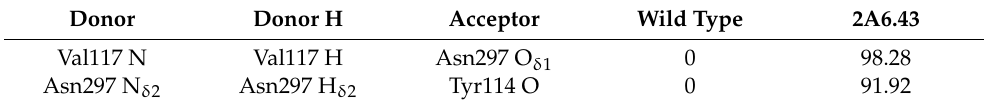
Figure 11. Structural change in CYP2A6.43 ( A – C ). The wild type and CYP2A6.43 are shown in cyan and light blue, respectively. Nitrogen, oxygen, and hydrogen are displayed in blue, red, and white, respectively, in the stick model. Iron is shown as an orange sphere by a model written as van der Waals radius. The red dotted lines indicate the hydrogen bonds. The red arrows indicate the shift in CYP2A6.43. Table 8. Hydrogen bond formation involved in the structural change in